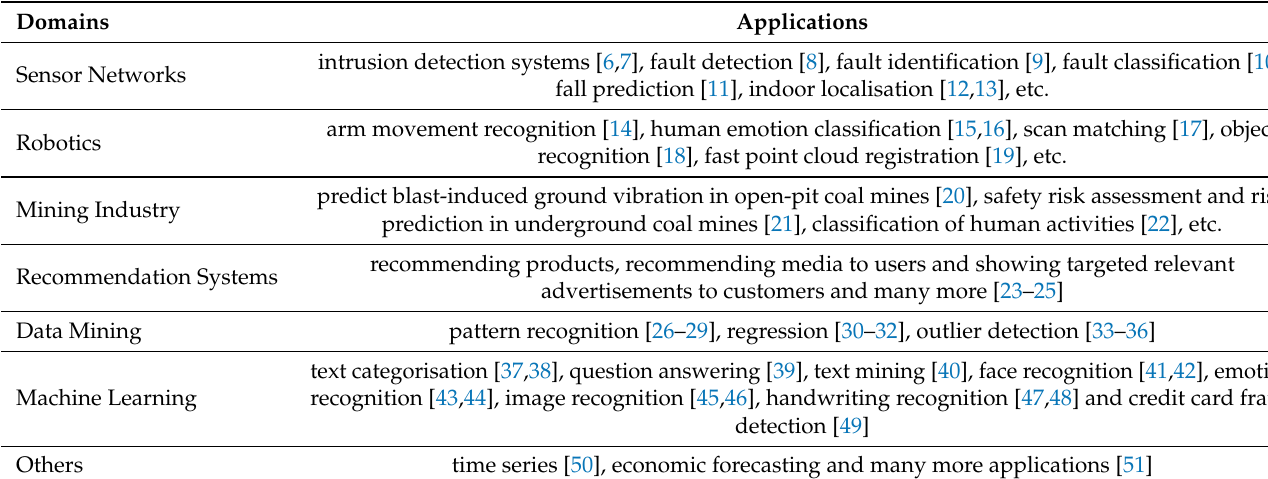
Table 1. Applications of kNN